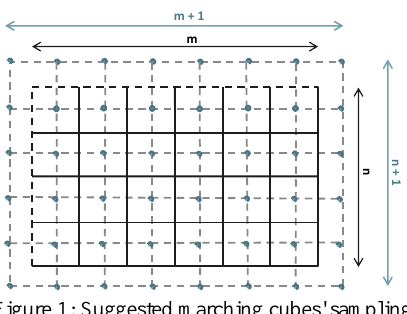
Figure 1: Suggested marching cubes' sampling